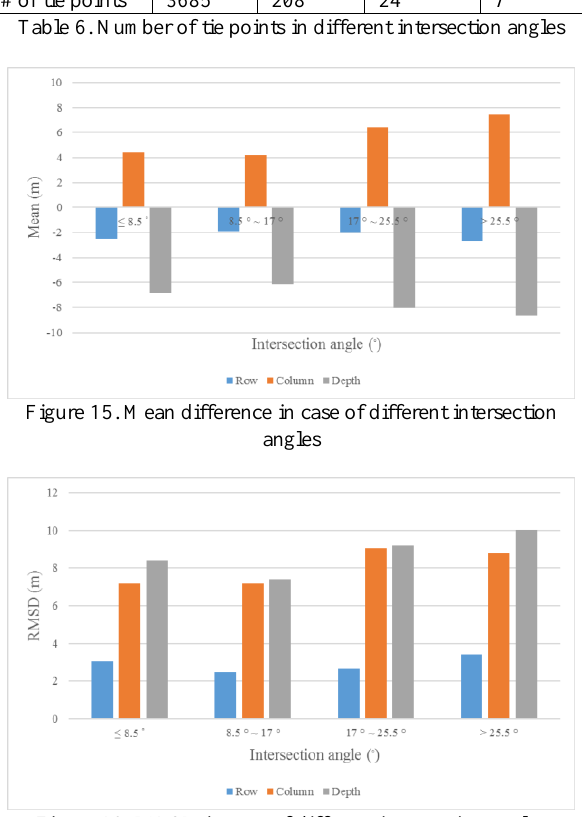
Figure 16. RMSD in case of different intersection